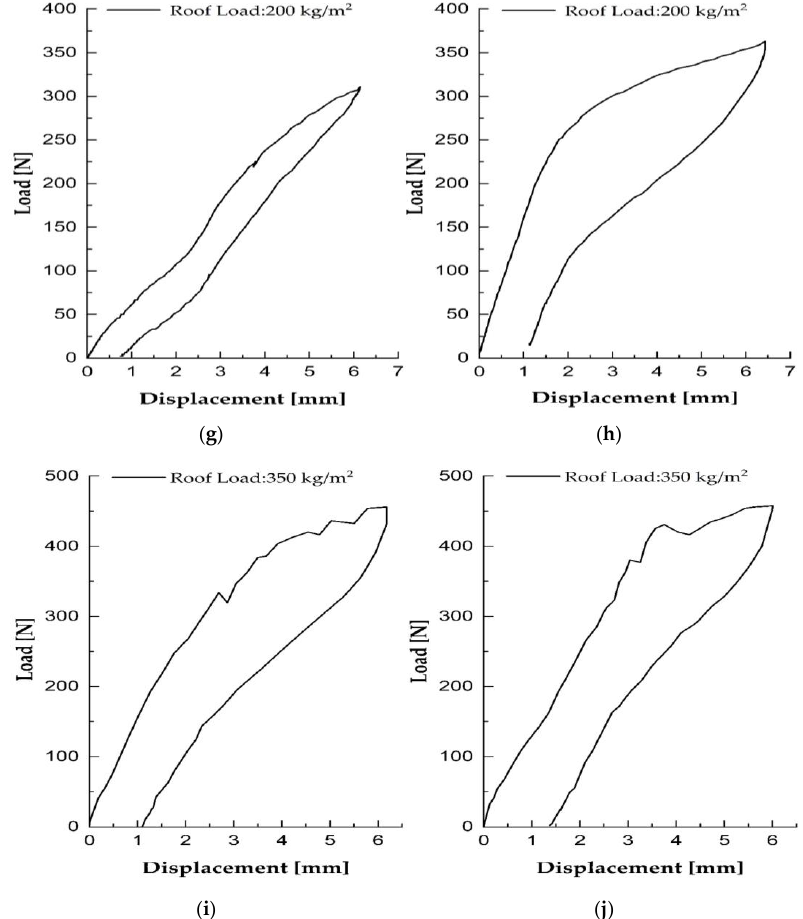
Figure 10. Hysteresis curves from ten horizontal load tests. ( a , c , e , g , i ) are for the frontal direction; ( b , d , f , h , j ) are for the lateral direction. ( b , d , f , h , j ) are for the lateral